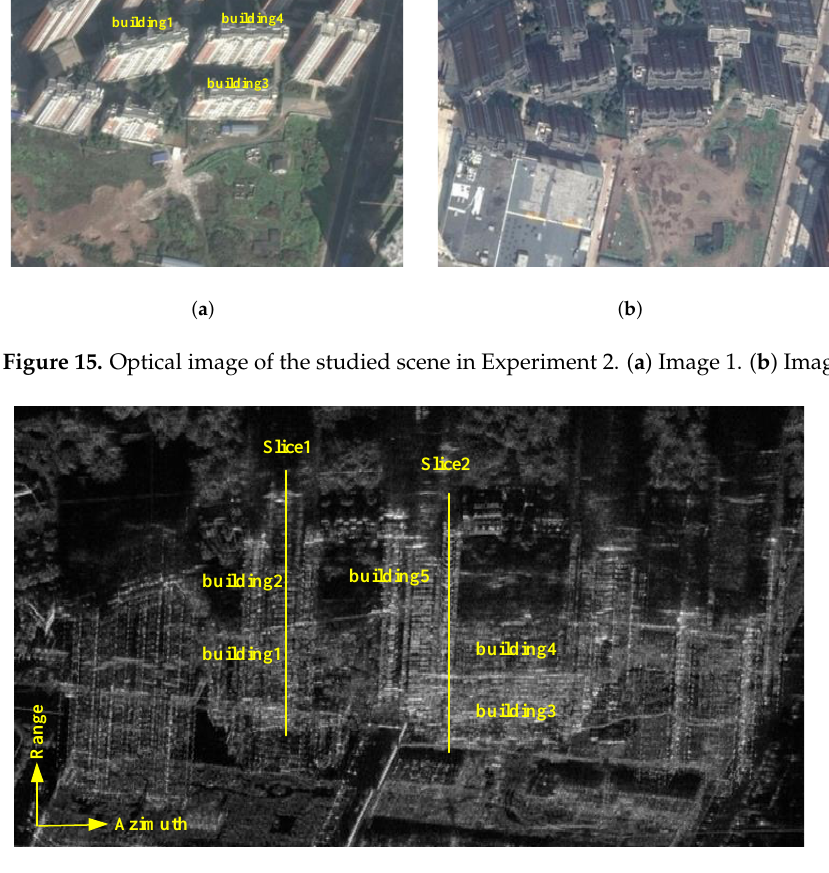
Figure 16. SAR image of the studied scene in Experiment